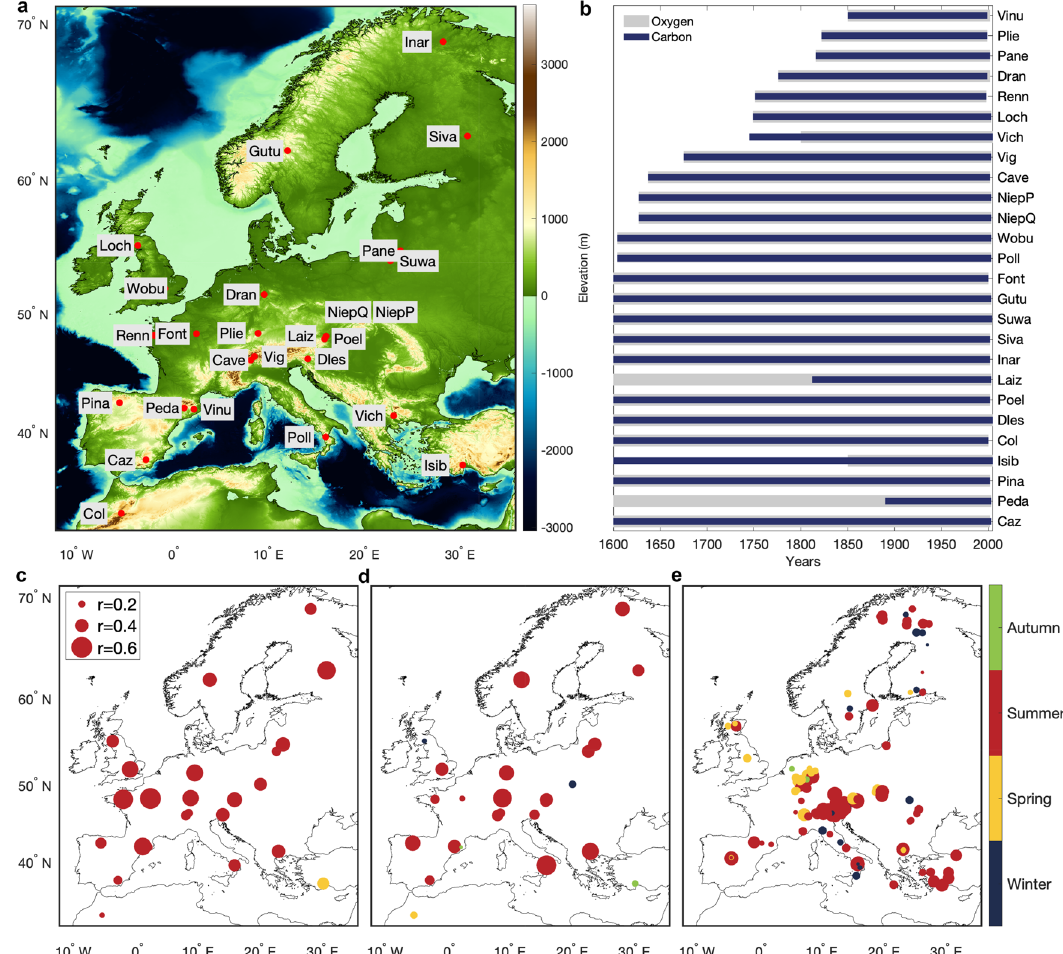
Fig. 1 Overview of the European tree-ring isotope network. a Spatial distribution of the tree sites across Europe with annually resolved isotope records of δ 18 O and δ 13 C. b Temporal distribution of δ 18 O and δ 13 C records as bars. c – e Seasonal response of carbon, oxygen and tree-ring records 62 , respectively, with SPEI-2. Shown is the highest leading seasonal correlation with SPEI. Over the 1901 – 1998 period the highest correlation for each site is assigned to the closest gridboxes within 60